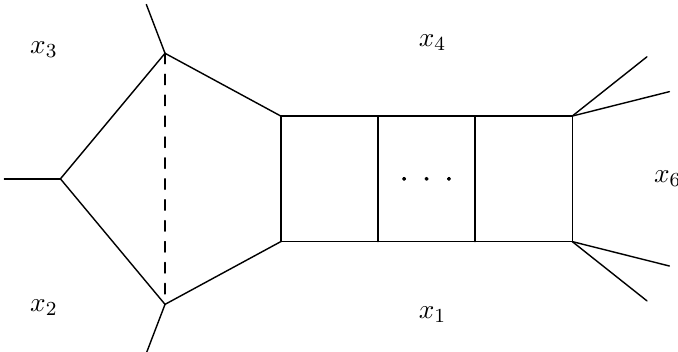
Figure 2 . The seven- or higher-point pentabox ladder integral, labelled by dual coordinates, where the ladder is formed out of L (cid:0) 1 loops. The dashed line represents a numerator factor that renders the integral